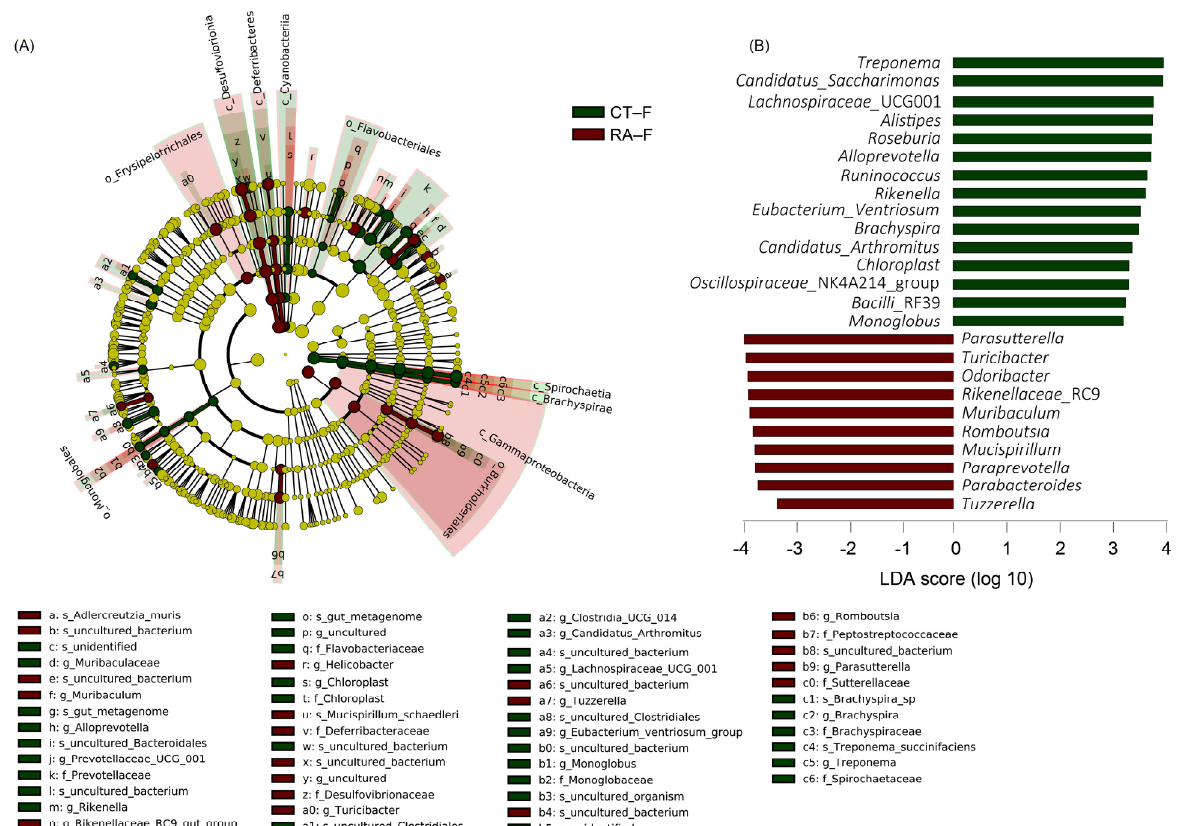
Figure 3. Linear discriminant analysis effect size (LEfSe) analysis of fecal microbiome in healthy control and RA mouse samples. ( A ) Cladogram constructed by LEfSe indicating alternations between healthy control and RA samples. Regions in green indicate taxa enriched in healthy controls and regions in red indicate taxa enriched in RA mice. The bottom of the cladogram shows the differing taxa. ( B ) LDA scores are described in a bar graph.